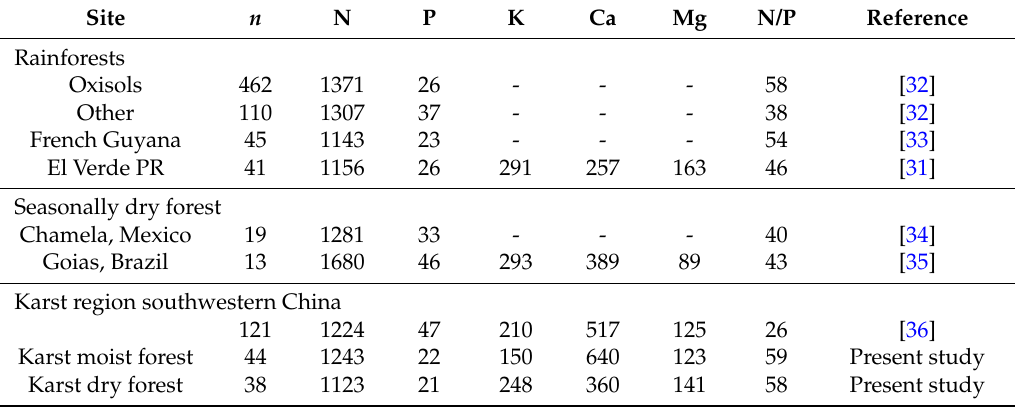
Table 7. Average leaf nutrient concentrations in a range of humid and dry tropical forests (mmol/kg).